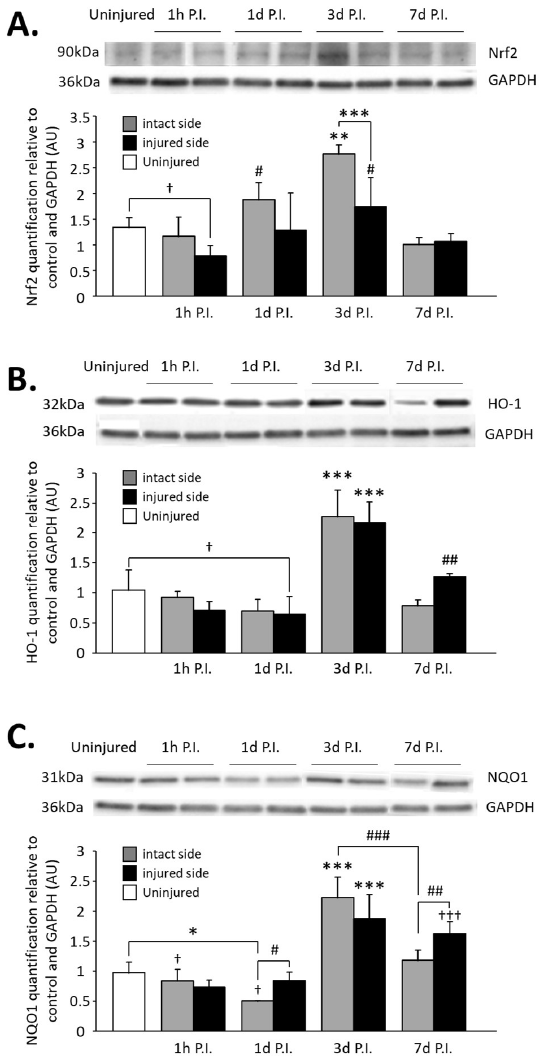
Figure 7. Quantification of Nrf2 and two of its effectors, HO-1 and NQO1, in the C3–C6 spinal cord following C2 hemi-section. ( A ) Representative blot and associated quantification of Nrf2